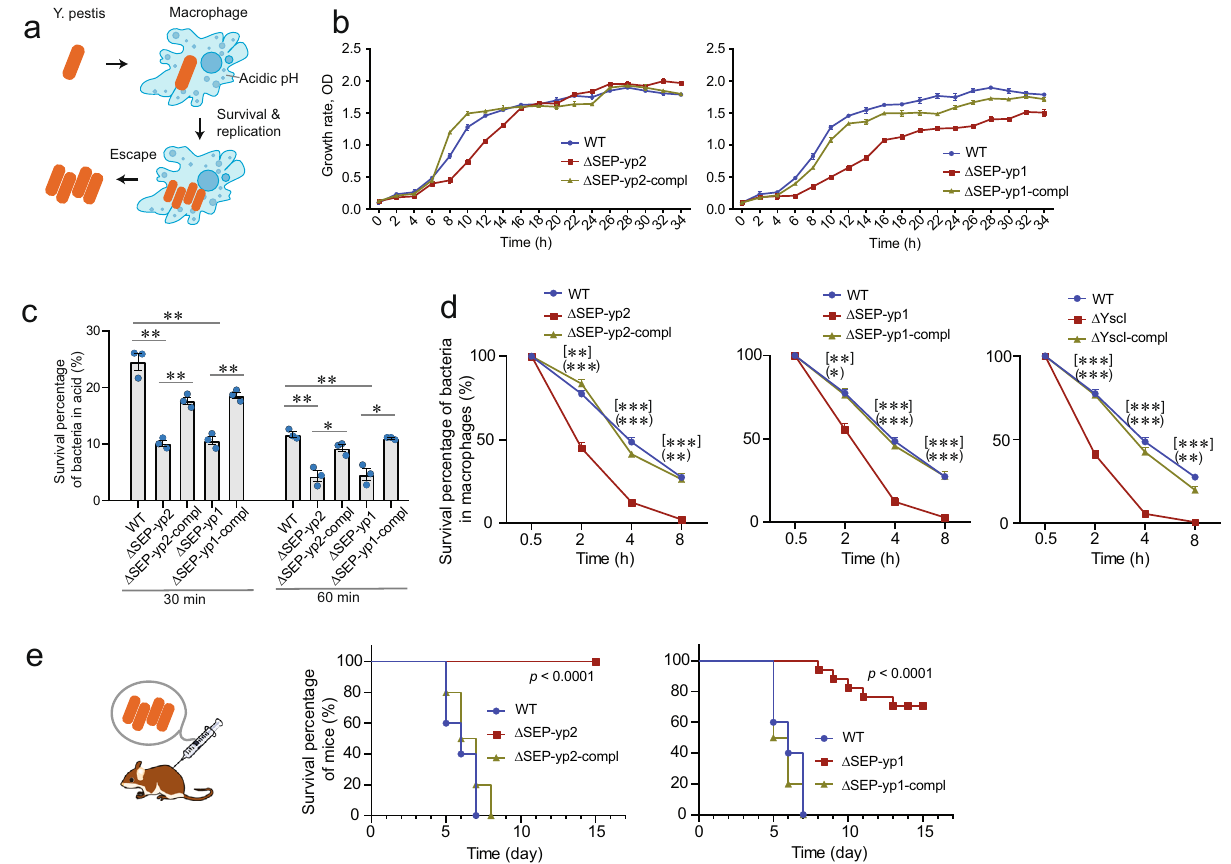
Fig. 4 Phenotype screening of SEP-yp1 and SEP-yp2 by a comparative assessment of WT, Δ SEP, and Δ SEP-compl bacterial strains. a Schematic showing the interaction of Y. pestis with macrophages. The bacteria enter macrophages and develop antiphagocytic capability, followed by escape and transmission. b Plot of bacterial growth rate showing the in fl uence of SEP deletion on bacterial proliferation and growth. N = 3 in each group. Mean ± SEM. c Plot of bacterial survival percentage in acidic environment showing the capability of acidic resistance effected by SEP deletion. N = 3 in each group. Unpaired t test. Mean± SEM. d Plot of bacterial survival percentage in macrophages affected by SEP deletion. N = 3 in each group. Mean ± SEM. Unpaired t test. The p values of Δ SEP vs. WT are shown in [] at each time point, and Δ SEP-compl vs. Δ SEP in (). For panels c and d , * p value < 0.05, ** p value < 0.01, and *** p value < 0.001. e Animal survival curve showing the bacterial virulence by subcutaneous injection to mice. WT, N = 10; Δ SEP, N = 20; and Δ SEP- compl, N = 10. A log-rank test was used to calculate the statistical signi fi cance. Note that some error bars are too small to be